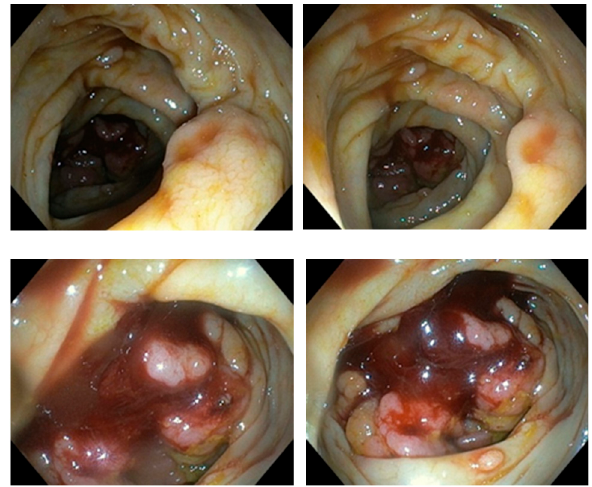
Figure 3. Endoscopic picture of cecal region tumor by Novel Motorised Spiral Enteroscope.